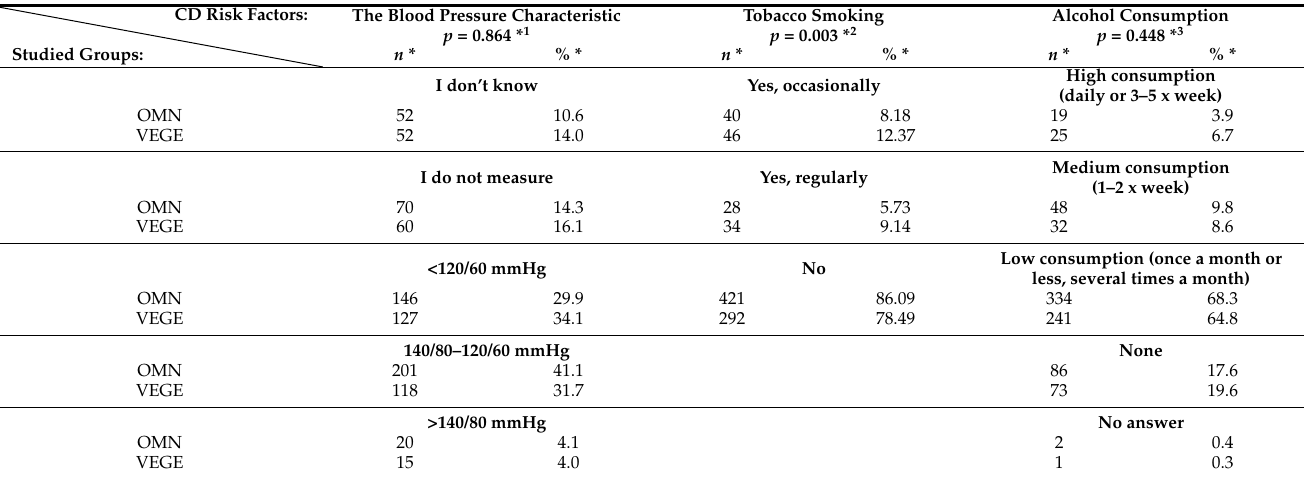
Table 4. Characteristics of the cardiovascular disease risk